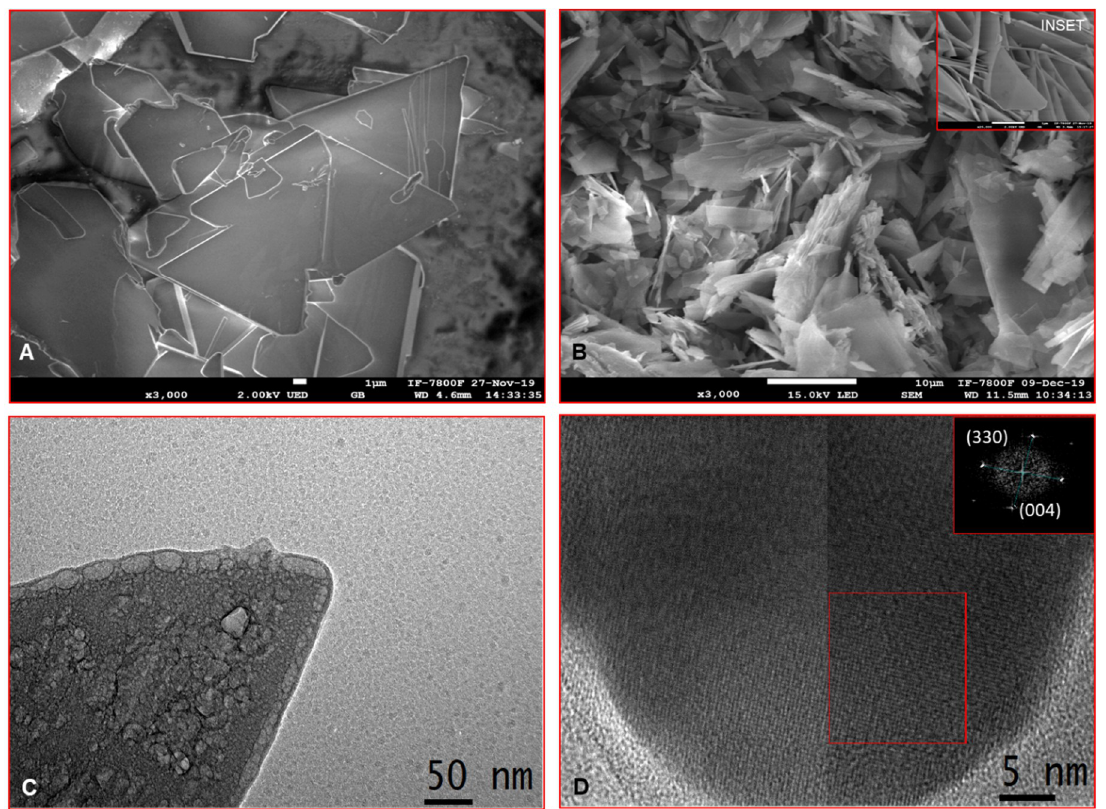
Figure 5. SEM and TEM micrographs of the microstructure and morphology of samples obtained after the CCSG process. ( A ) Control sample, ( B ) experimental sample, ( C ) bright-field TEM micrographs corresponding to OCP (control), ( D ) HRTEM fringes, and FFT analysis (inset) corresponding to the hydroxyapatite crystal structure (experimental).